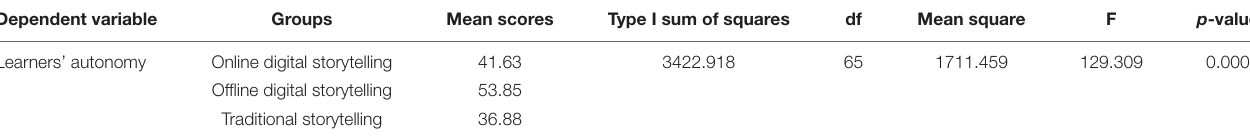
TABLE 3 | ANOVA of learners’ autonomy scores.